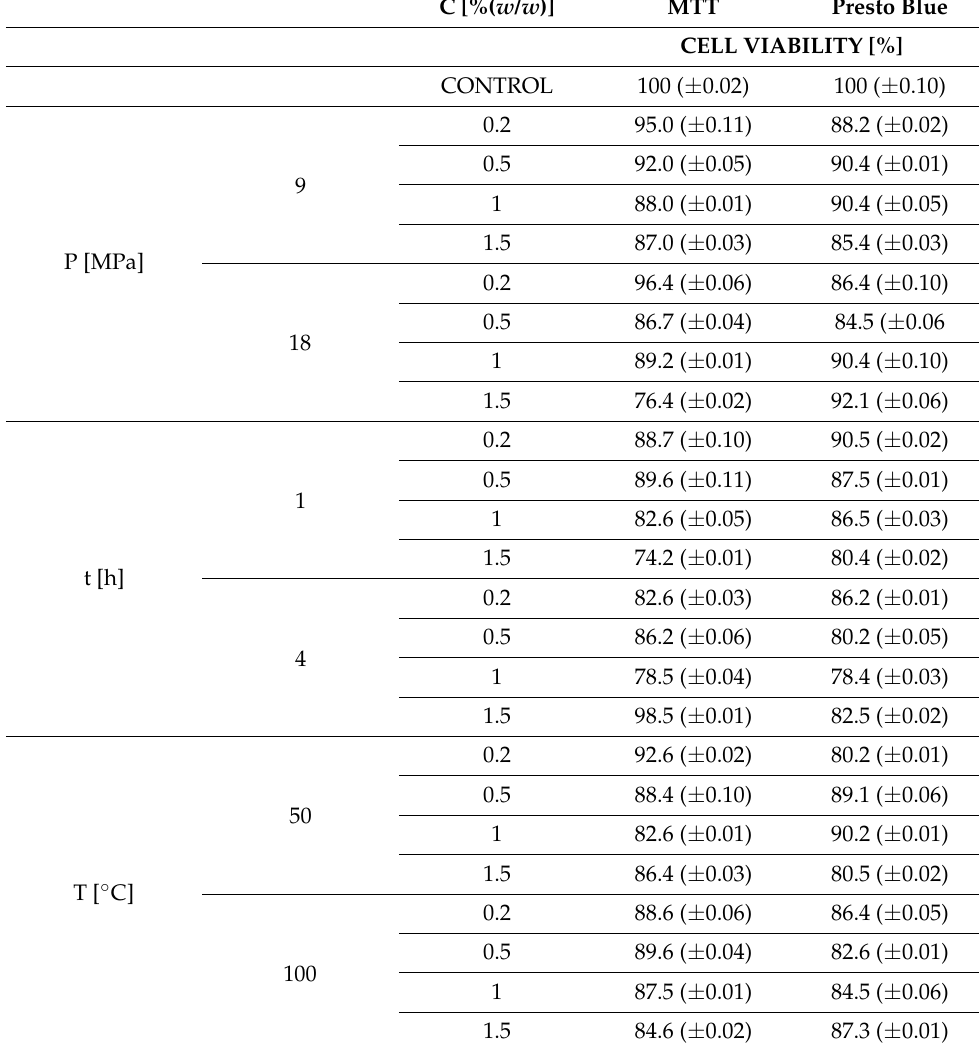
Table 5. Influence of the concentration of the applied additive nGO and the foaming process condi- tions: pressure P sat , temperature T sat , saturation time t sat on the viability of cells. C [%( w / w )]